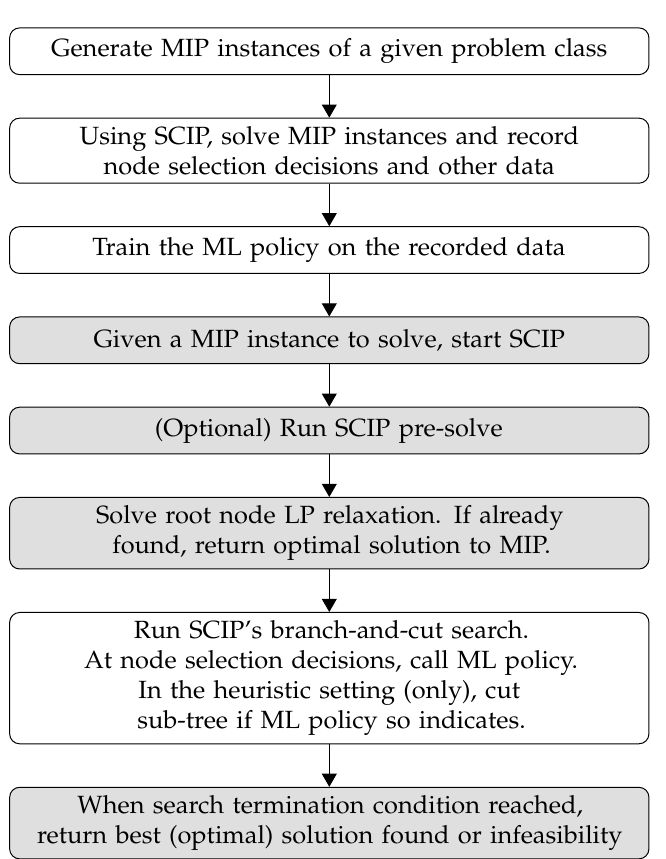
Figure 2. Flowchart of the ML-based approximate node pruning, for a given problem class. Shaded boxes are standard SCIP steps. The first three steps are training, which is performed once for a problem class; the remaining steps are the online solving, which is performed for a given input MIP instance to be